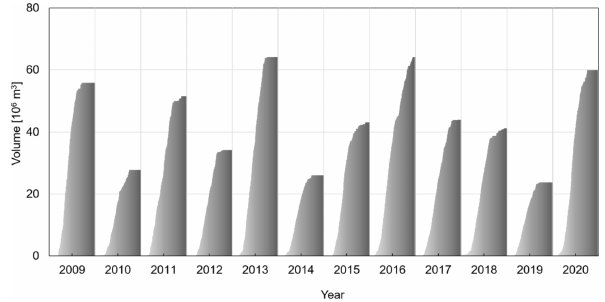
Figure 7. Cumulative ablation [10 6 m 3 ] in May–November (2009– 2020) for